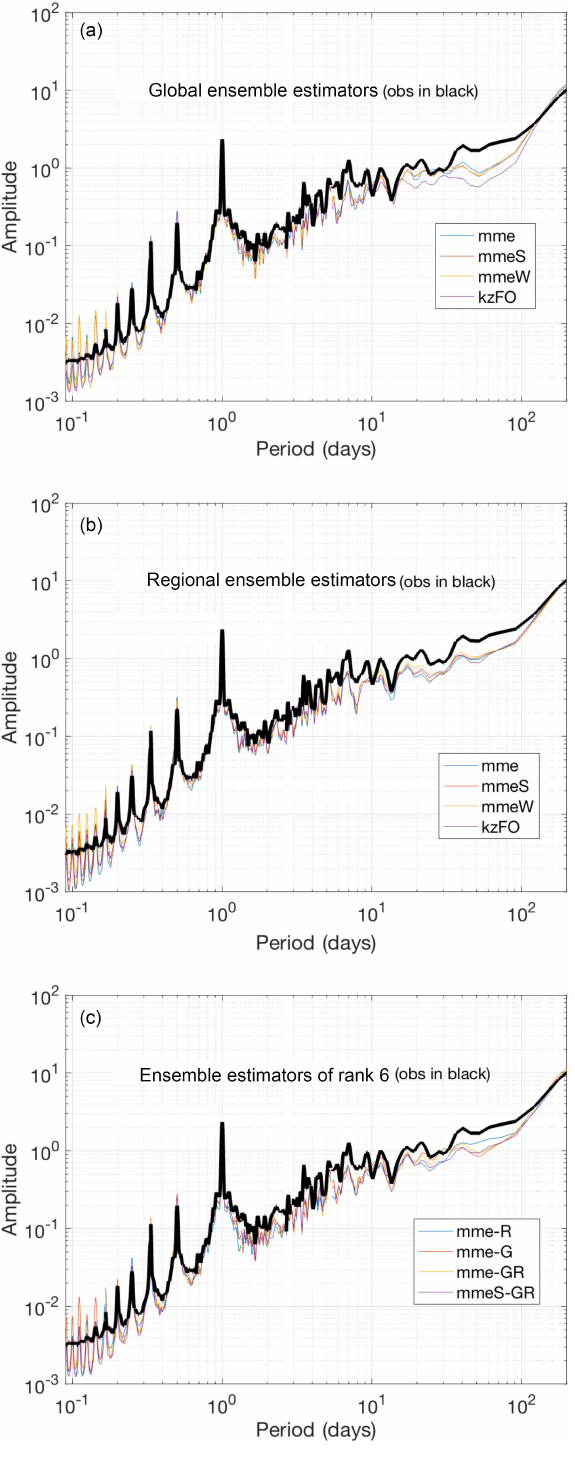
Figure 12. Spectra behaviour of the ensemble treatments: full global ensemble (a) ; full regional ensemble (b) ; mme of the six most frequently present global and regional models and the hybrid ensemble calculated with mme and mmeS ensemble methods (c)